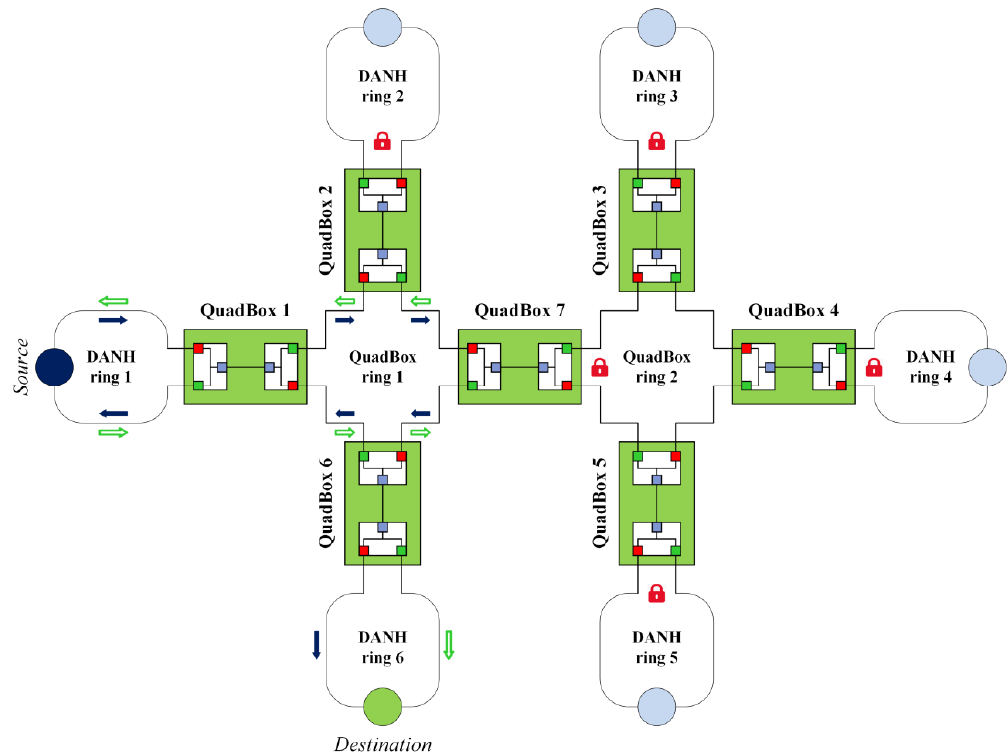
Figure 9. Filtering unicast traffic under the EPL